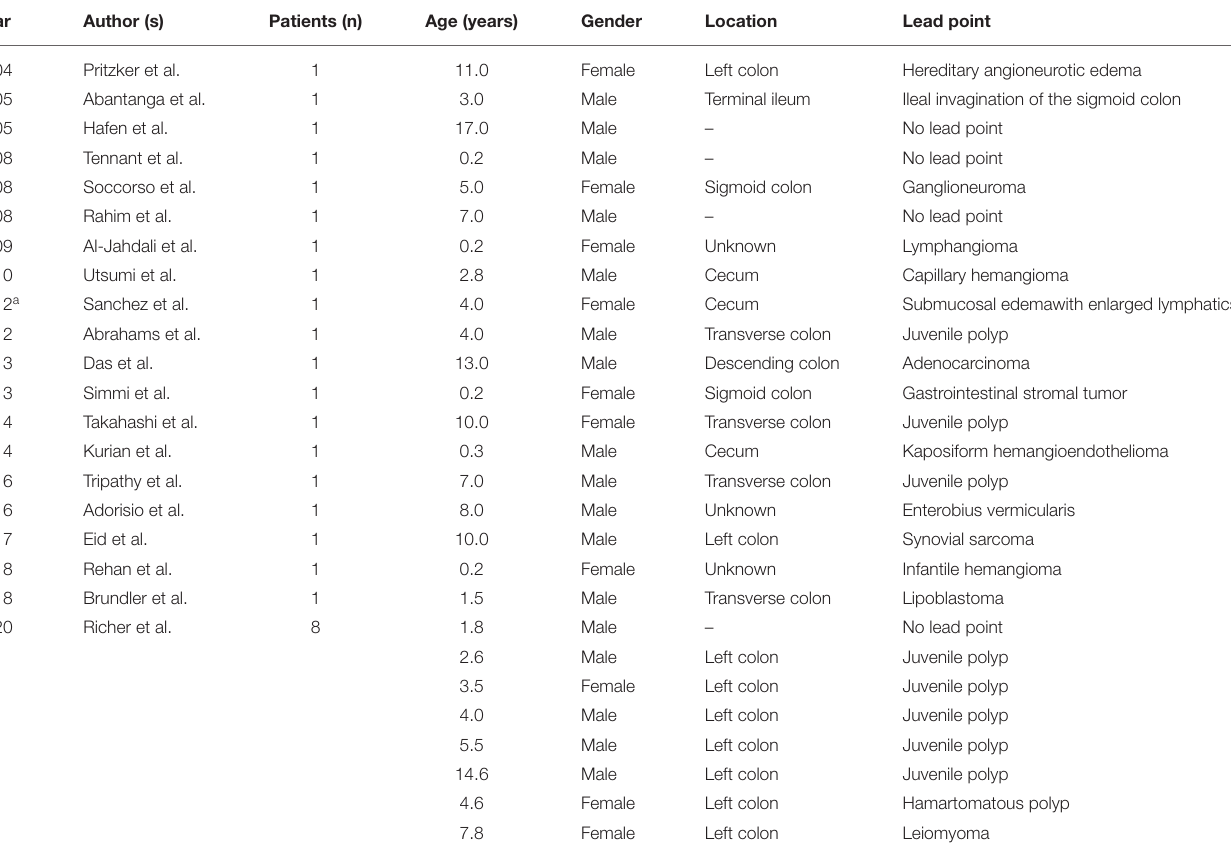
TABLE 3 | Studies from 2000 in order of year of publication ( n =